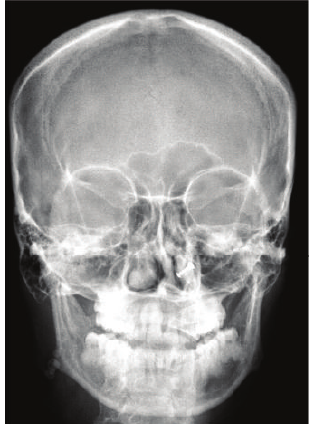
Figure 5: PA skull view showing the calcific structures in the right cheek